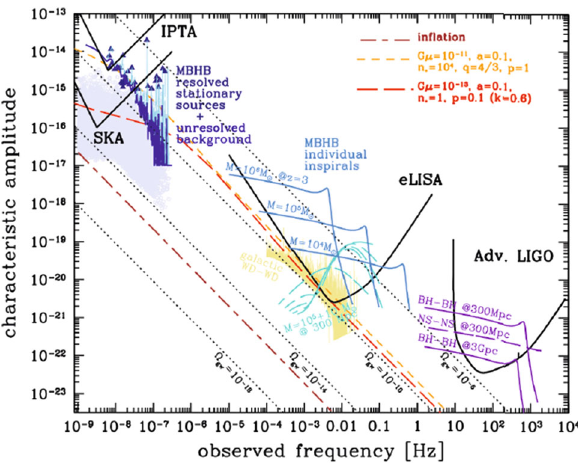
Fig. 80 Examples of detector sensitivity curves compared to potential gravitational-wave signals, compar- ing the characteristic strain signal h c ( f ) to the characteristic strain noise h n ( f ) . Image reproduced with permission from Janssen et al. (2015), copyright by the authors